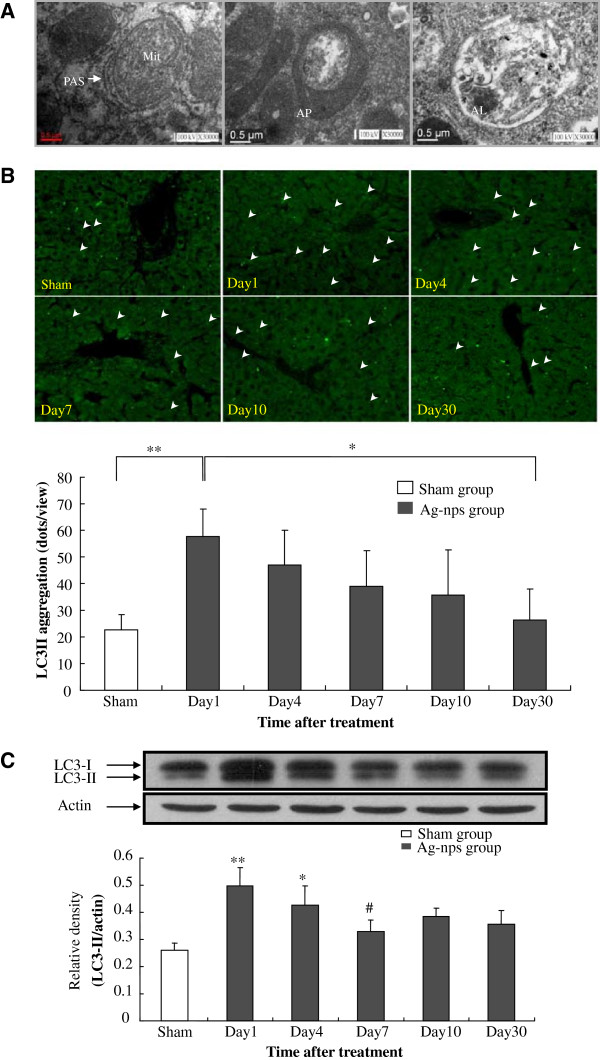
A transient increase of autophagy in rat liver. Changes in autophagic structures (day 1) (A), LC3-II aggregation (day 1–30) (B), and LC3-II protein expression (day 1–30) (C) in liver tissues at various time points following an i.p. Injection of Ag-nps. Experiments were carried out as described under Materials and Methods. A: TEM images of rat liver tissues. Scale bar = 0.5 μm. PAS = phagophore assembly site; Mit = mitochondria; AP = autophagosome; AL = autophagolysosome. B: upper panel: LC3-II aggregation was analyzed by immunofluorescence staining under fluorescence microscopy. Lower panel: quantitative analysis of FITC-LC3-II aggregation from each time points was estimated by counting the number of bright green dots, as arrows indicated (upper panel), under 200x amplification. Data were means ± SD of 8 individual rat experiment, *p < 0.05, **p < 0.01. C: LC3-II protein level changes based on Western blot analysis. Actin was used as a loading control. Values were expressed as means ± SD (n = 6), *p < 0.05 and **p < 0.01 versus sham group; #p < 0.05 versus Day 1 group.